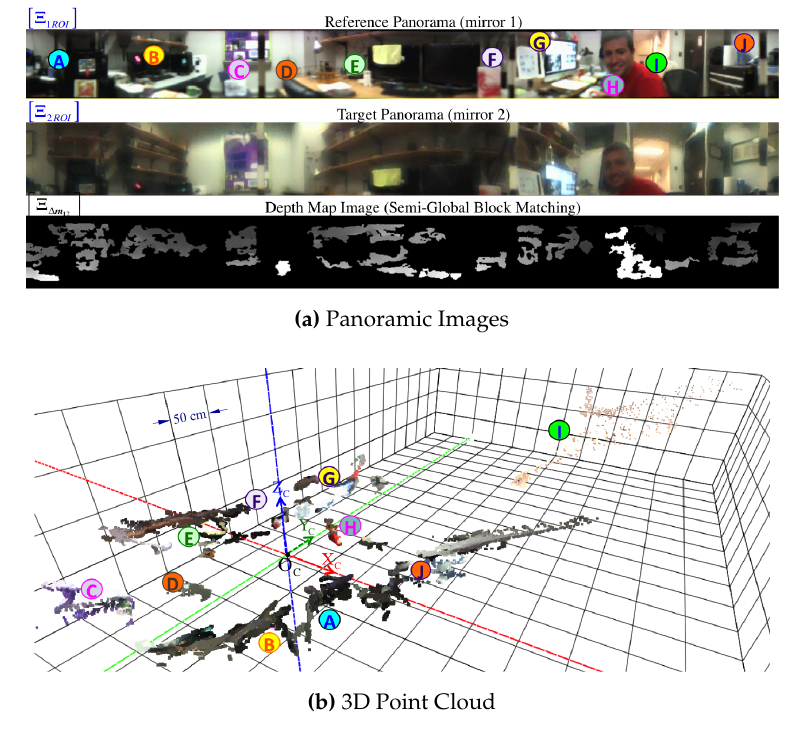
Figure 21. Real-life experiment using the 37mm-radius prototype and a single 2592 × 1944 pixels image where the rig was positioned in the middle of the room observed in Figure 13a. Some landmarks of the scene are annotated as following: A appliances, B monitors and shelf, C back wall, D chair, E monitors and shelf, F book, G monitors, H person, I hallway, J supplies. For the point cloud, the grid size is 0.50 m in all directions and points are thickened for